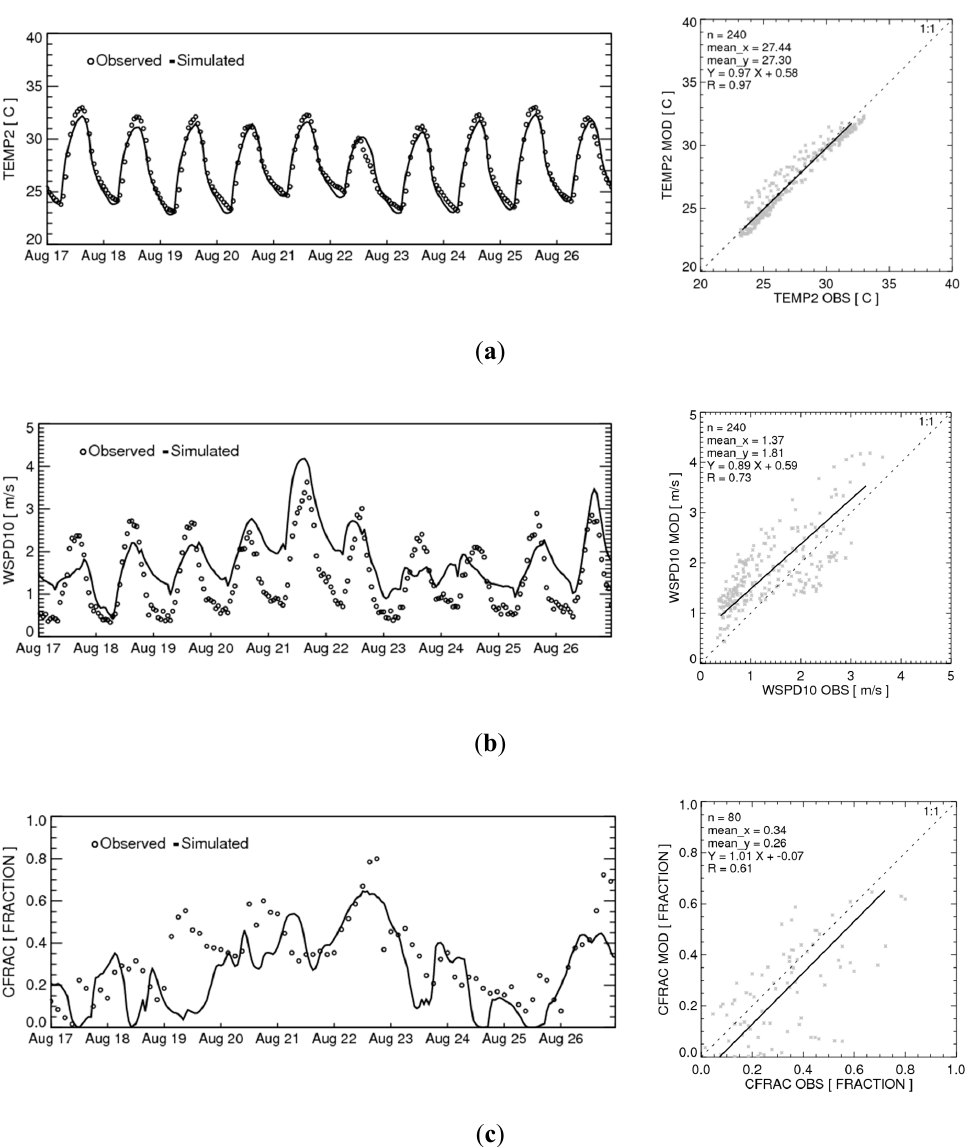
Figure 3. Modeled and observed 2-m temperatures ( a ), 10-m wind speeds ( b ), and cloud fractions ( c ) averaged spatially for the 3-km domain.